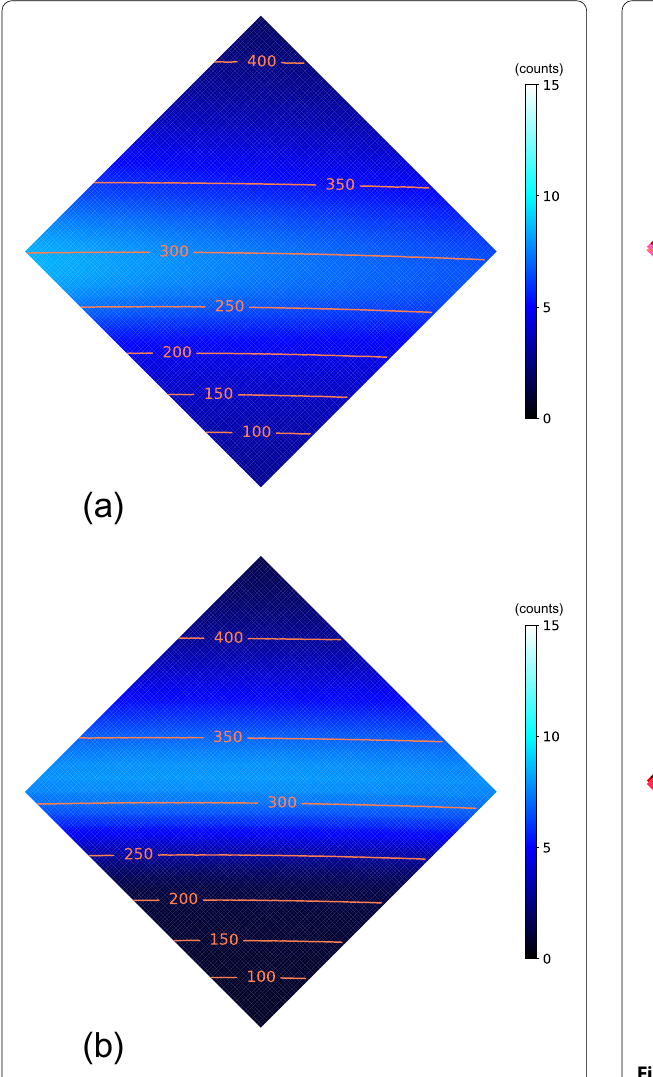
Fig. 6 Difference of the EUV images shown in Fig. 1 from the simulated images in Fig. 5 for the periods 21:08:26–21:09:25 UT ( a ) and 21:18:38–21:19:37 UT ( b ) on December 26,